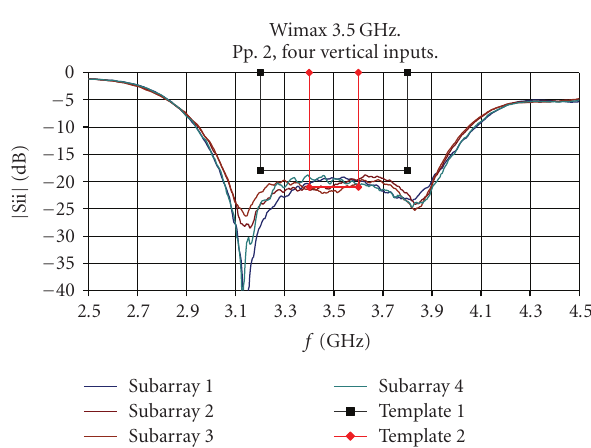
Figure 10: Antenna subarrays. Return losses for each input.